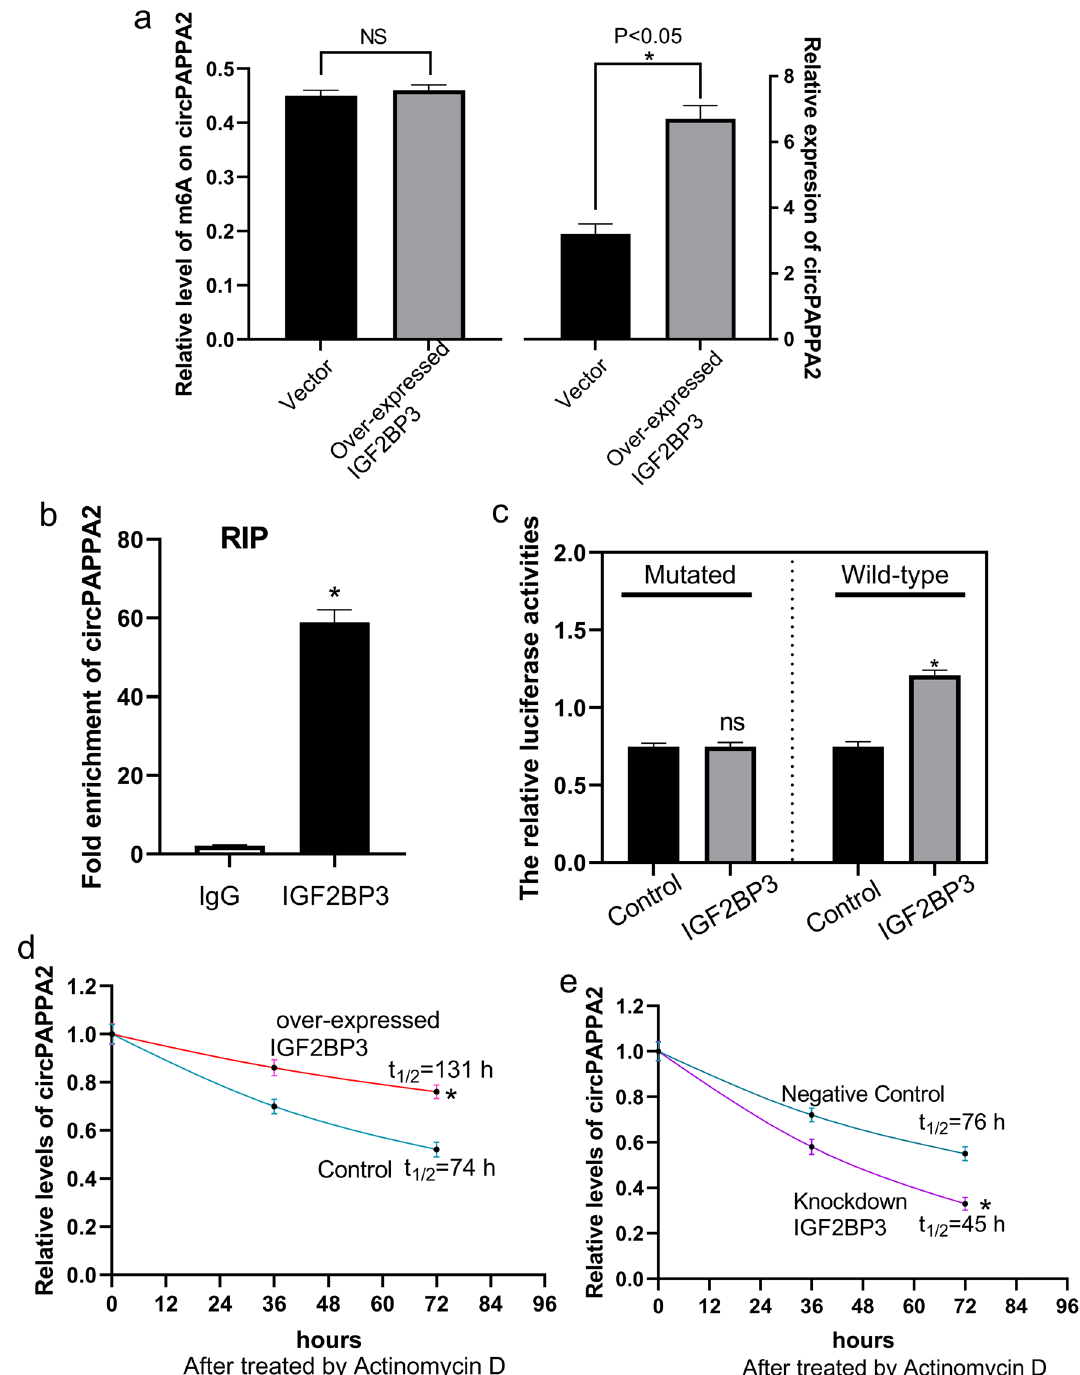
Figure 6. Through overexpression experiments, insulin-like growth factor 2 mRNA binding protein 3 ( IGF2BP3) was found to increase circPAPPA2 expression but have no effect on the levels of m6A on circPAPPA2 ( a ). RNA immunoprecipitation (RIP) revealed that IGF2BP3 can bind to circPAPPA2 ( b ). Luciferase assay results showed that downregulation of IGF2BP3 can downregulate circPAPPA2 expression in an m6A- dependent manner ( c ). In an analysis of circPAPPA2 stability, after transcriptional inhibition using actinomycin D, overexpression of IGF2BP3 increased the circPAPPA2 half-life ( d ); knockdown of IGF2BP3 in TEV1 cells shortened the circPAPPA2 half-life ( e ) (all * P <